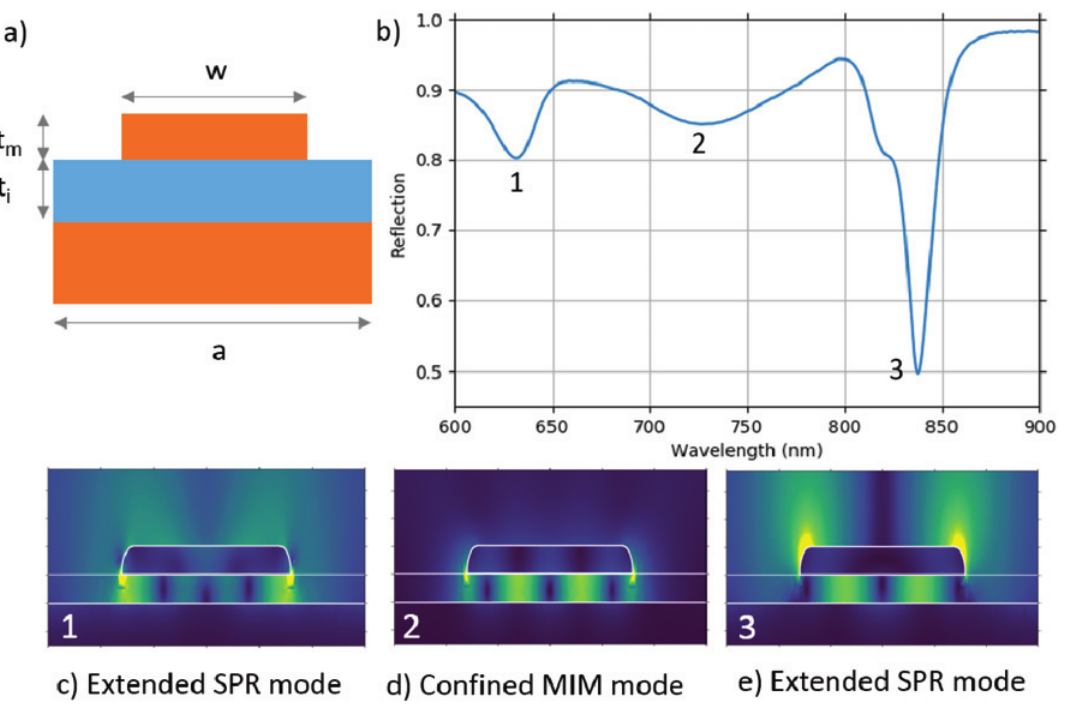
Figure1: (a) Schematicofthe structureshowingtop metalthickness, t m , insulator thickness t i resonatorwidth, w ,andperiod.(a, b)Spectrum and identi fi cation the various modes supportedby the structure. (d) Plot of the electric fi eld of the con fi ned MIM mode. E fi eld plots (c) and (e) are of the SPR modes at 640 and 840 nm respectively.